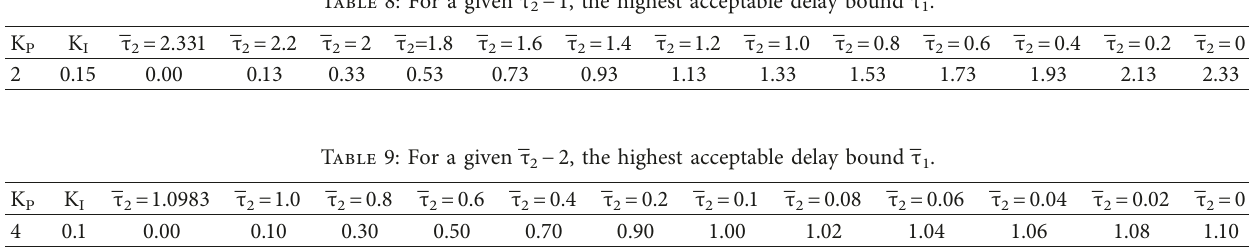
Table 8: For a given τ ̅